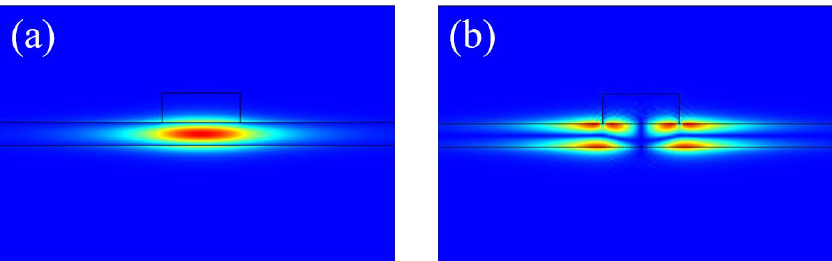
Figure 5. The electric field distribution of TM bound mode: ( a ) vertical component |𝐸 𝑧 | ; ( b ) horizontal component |𝐸 𝑦 | .